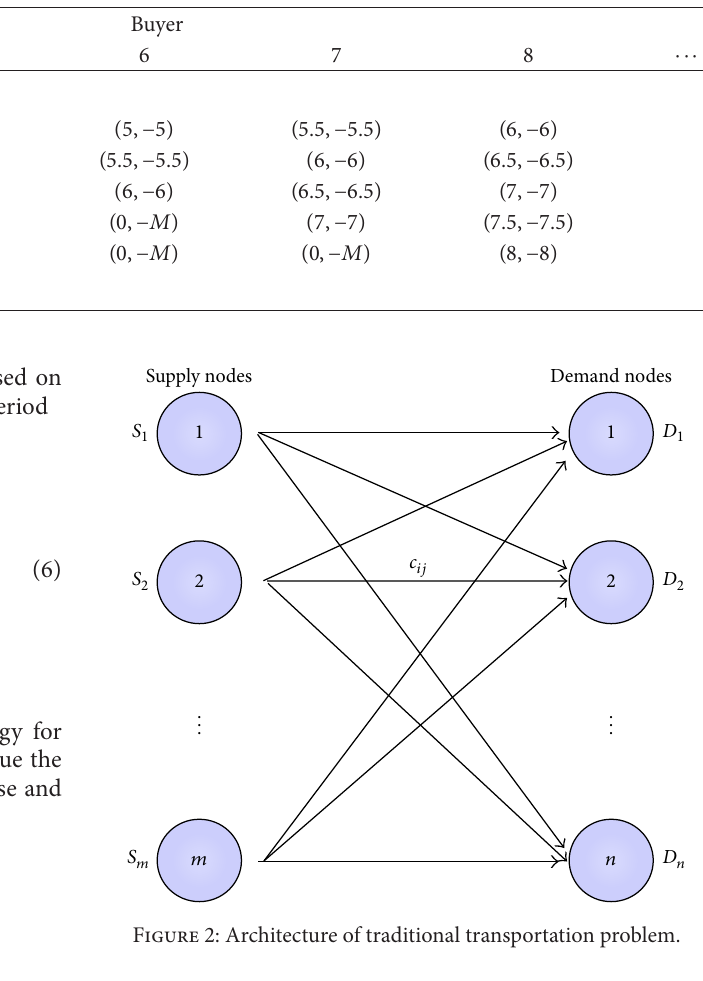
Table 1: Payoff table ( 𝑝 𝑠 𝑖𝑗 , −𝑝 𝑑 𝑖𝑗 ) for transaction game.